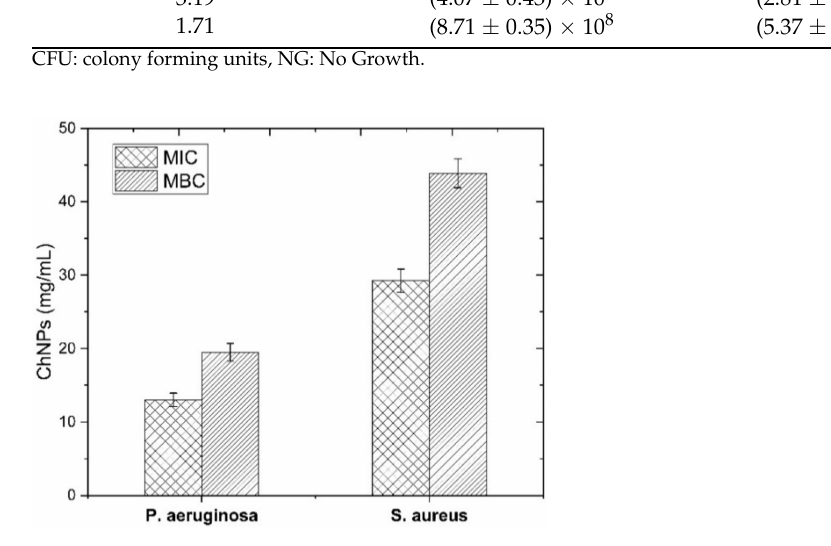
Figure 2. MIC and MBC levels of bacteria strains after supplementing with ChNPs at different